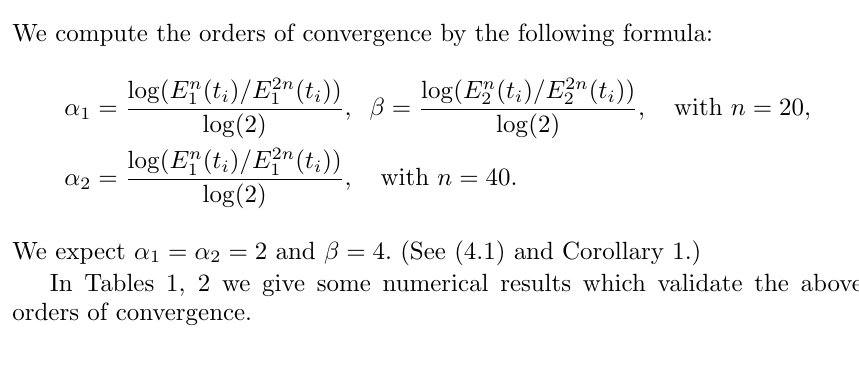
Table 1. Errors and convergence orders for the composite midpoint rule.